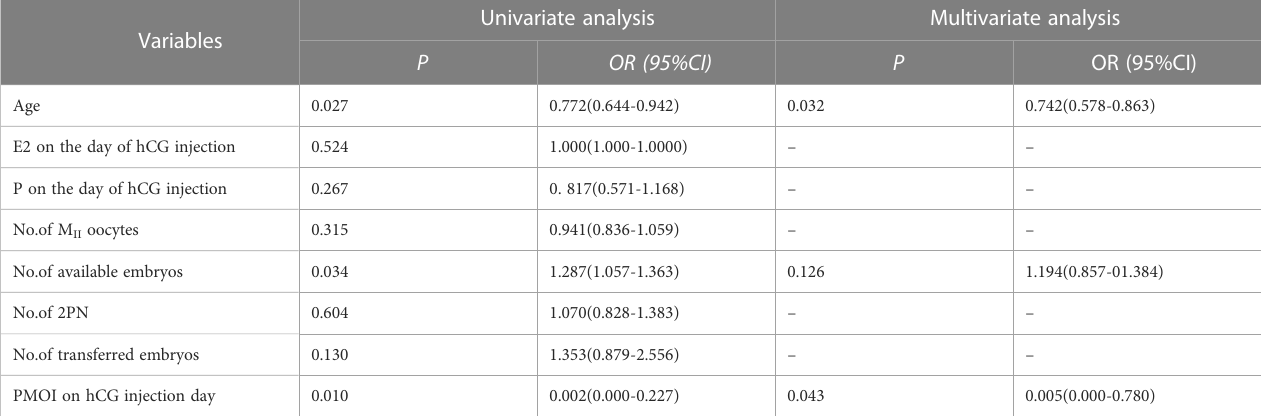
TABLE 2 Univariate and multivariate analyses of clinical